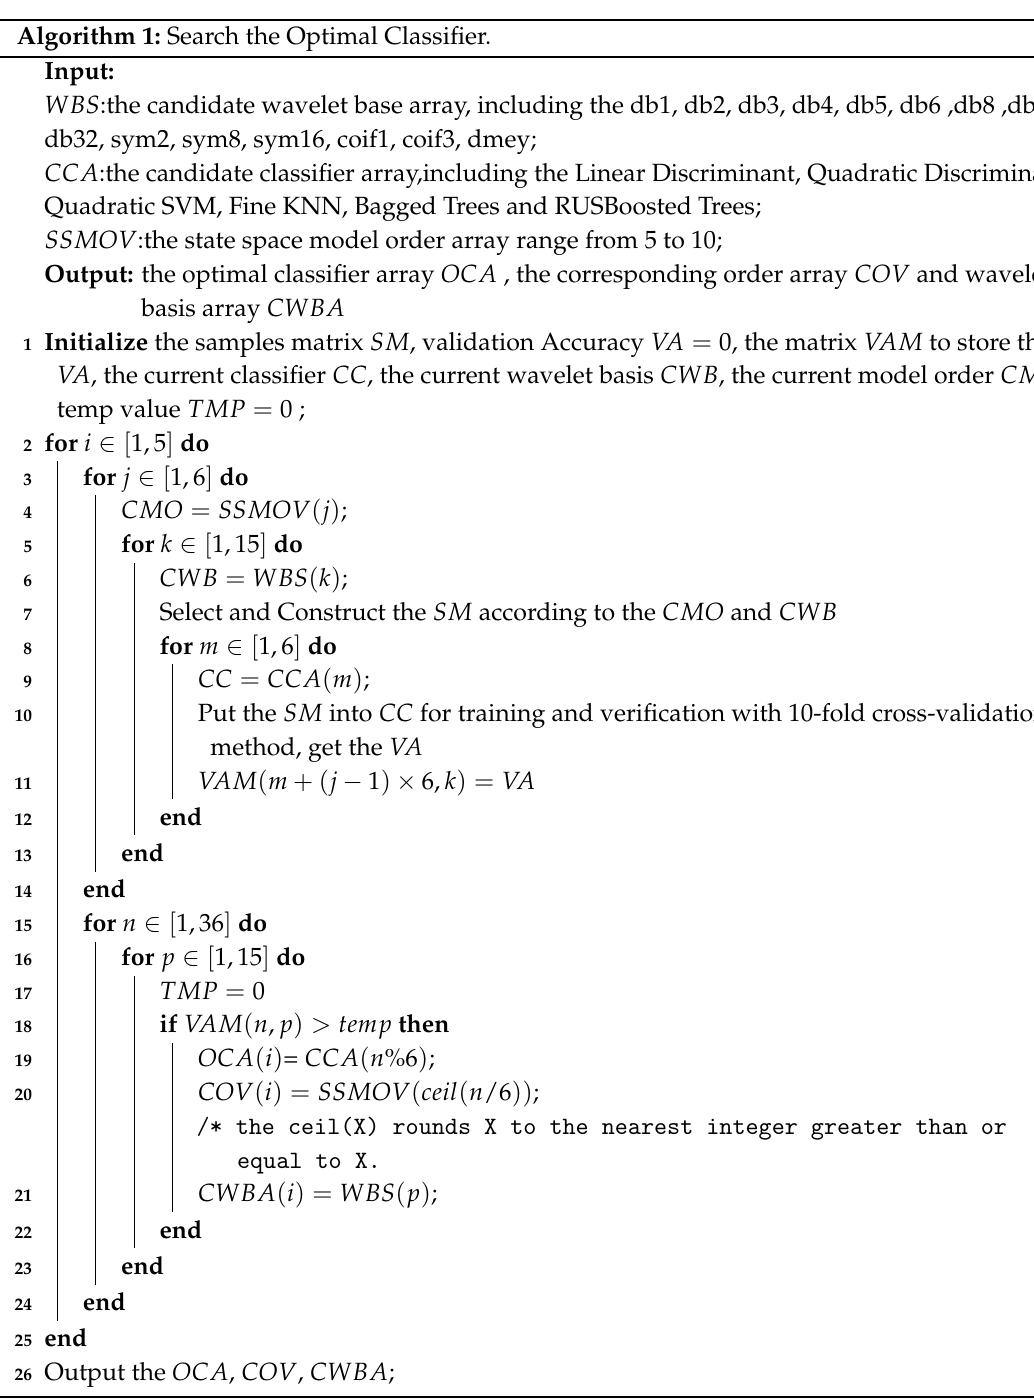
Figure 2. The candidate wavelets include db1, db2, db3, db4, db5, db6, db8, db16, db32, sym2, sym8, sym16, coif1, coif3 and dmey. The candidate model order is 5 to 10. The Following Tables 6–14 are the experiments results of the DRMS database without LEFs, in which the highest accuracy values are highlighted in